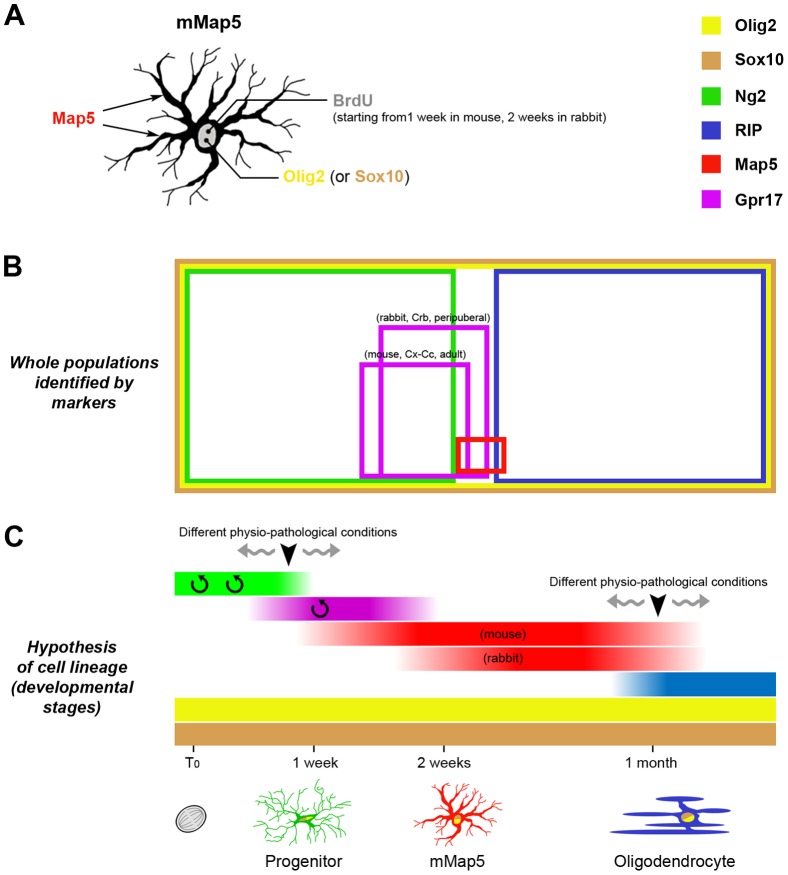
Schematic summary of the spatial and temporal distribution of several markers linked to the mMap5 cell population.A, The mMap5 cell population can be revealed by Map5/Olig2 double staining, and the subset of newly generated mMap5 cells by Map5/Olig2/BrdU triple staining (left). Double and triple staining with different markers (see colors in the legend on the right) can provide information on the spatial (B) and temporal (C) distribution of different subpopulations. B, The relative amount of each cell population revealed by different markers is indicated by colored squares. There is no overlapping between mMap5 and Ng2+cell population, and only a very small overlapping with the GST-π+ oligodendrocytes. C, Hypothesis on the time course for newly generated mMap5 cells by using endogenous and exogenous cell proliferation markers.